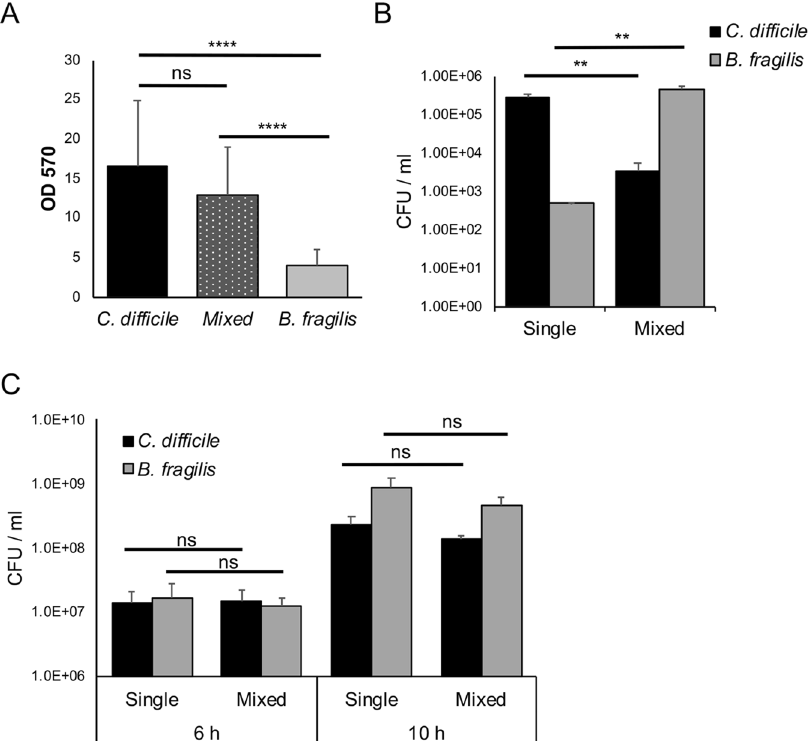
Figure 4. B . fragilis mediated inhibition of C . difficile in mixed biofilms. ( A ) Biofilm of C . difficile , B . fragilis and both species co-cultured (mixed) were grown for 24 h and stained with 0.2% CV, followed by measuring OD 570 . ( B ) Colony counts for both C . difficile (vegetative cells) and B . fragilis from mono and co-culture biofilms after 24 h. ( C ) Colony counts for both C . difficile (vegetative cells) and B . fragilis from mono and co-culture during planktonic growth. Data shown is the mean of 3 independent experiments in triplicates and error bars indicate SD, ** p < 0.005, **** p < 0.0001 as determined by one-way ANOVA, Tukey’s multiple comparison test, ns -not significant (significant differences were determined for C . difficile or B . fragilis mean CFU counts between single and mixed biofilms).